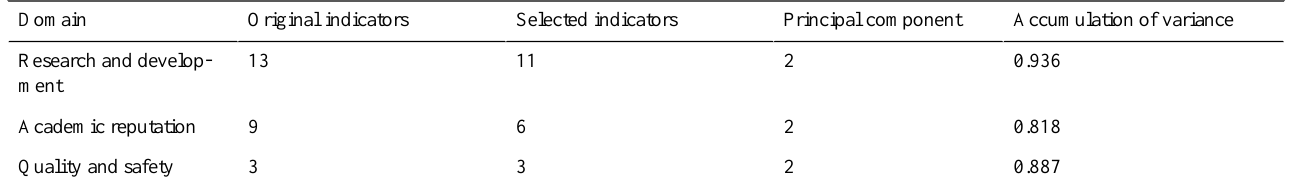
Table 4. Principal component analysis and categorical principal component analysis results of the three domains of the China Hospital Development